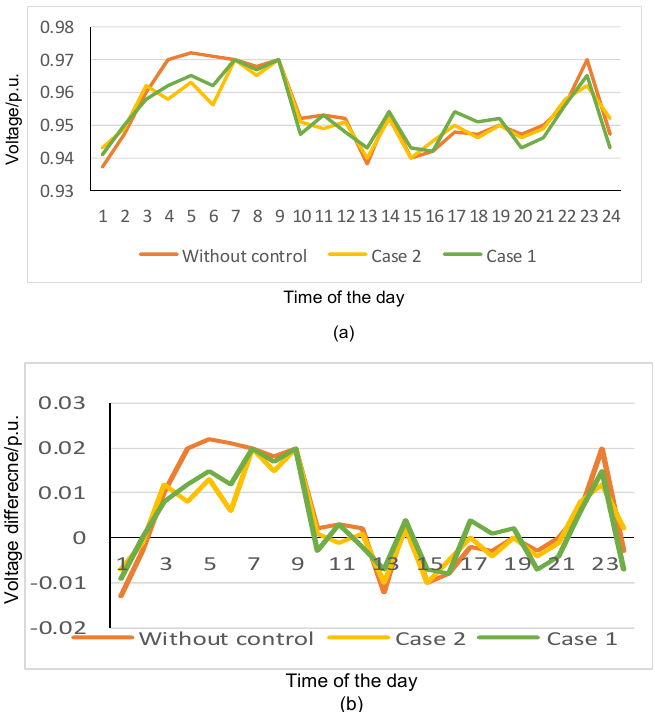
Figure 11. ( a ) Voltage curves of node 18 under different cases in a day. ( b ) Differences between actual and reference voltages under different cases in a day.